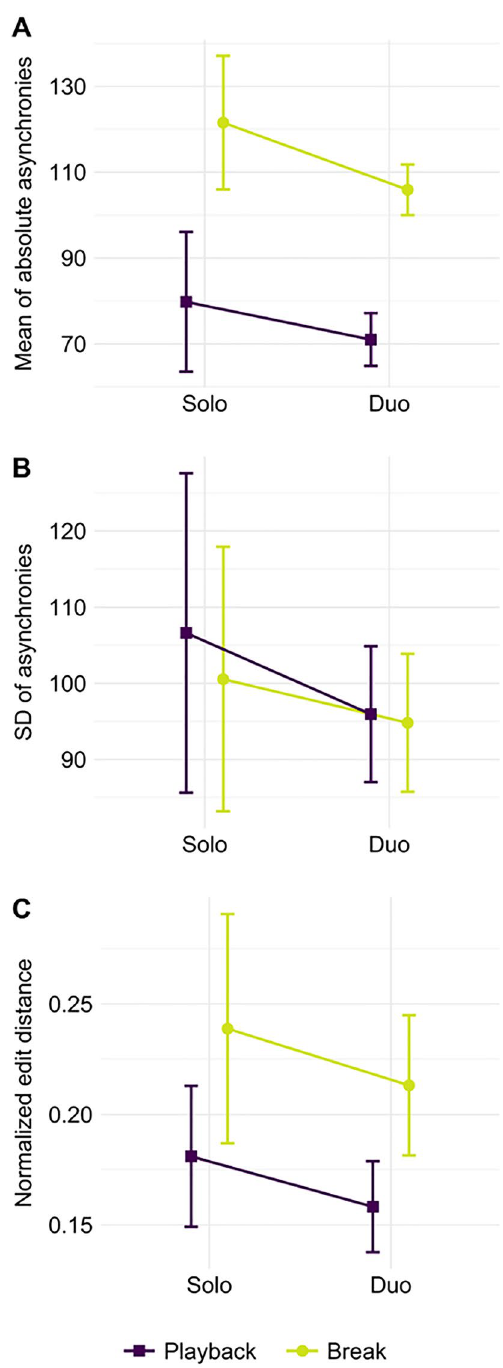
Figure 5. Measures of performance quality in duo and solo performances. ( a ) Mean of absolute asynchronies. ( b ) Mean of standard deviations of asynchronies. ( c ) Mean of normalized edit distances indicating how many times the wrong pads were played while drumming. Error bars represent + / − 1